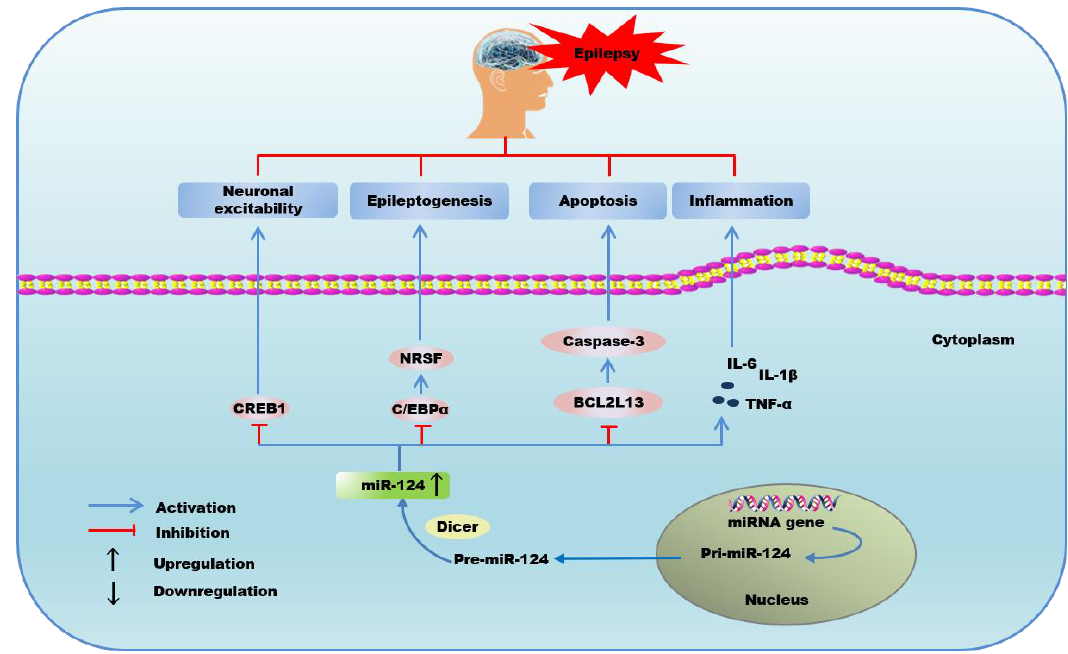
Figure 4. The possible mechanisms of the regulation of microRNA-124 in epilepsy or seizures.